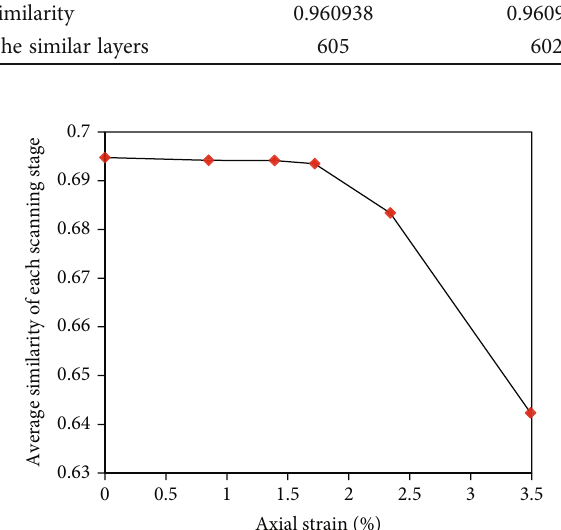
Figure 7: Average similarity in each scanning stage.